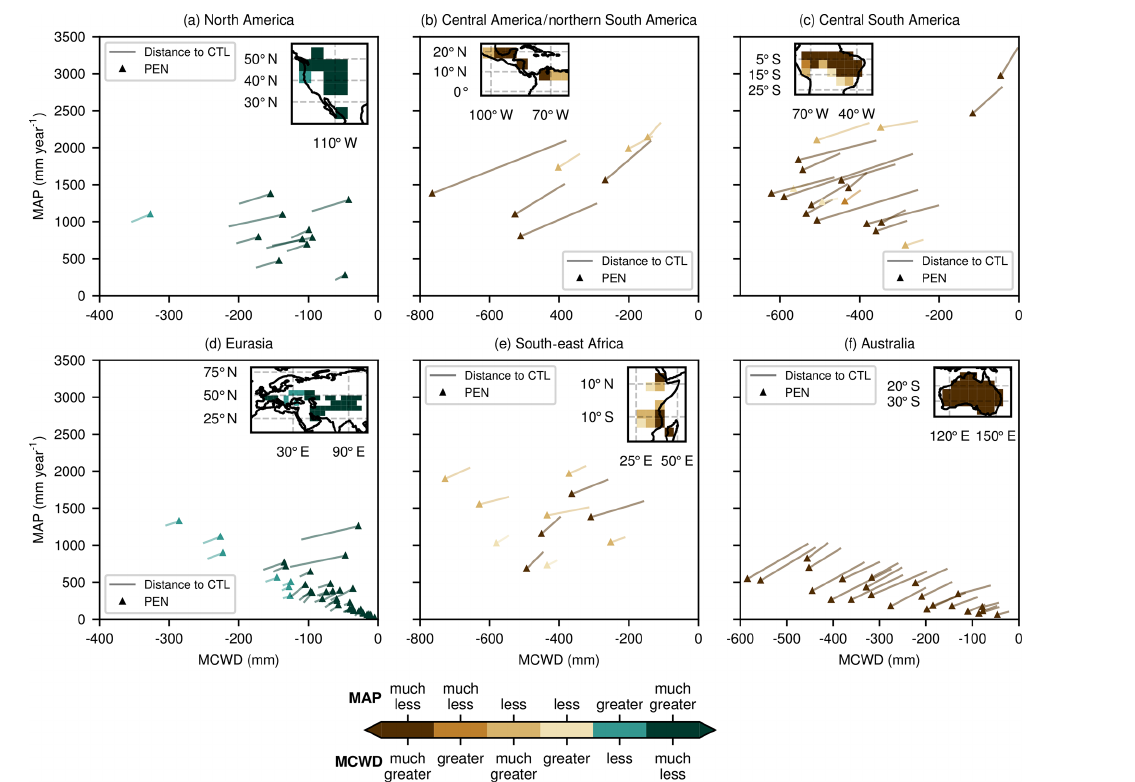
Figure 10. Changes in MAP and MCWD in the PEN scenario compared to CTL for different world regions. For every grid point shown in the zoomed map axes, we use markers (triangles) to show the value of both variables in the PEN scenario, and a straight line shows the distance to the value they have in the CTL